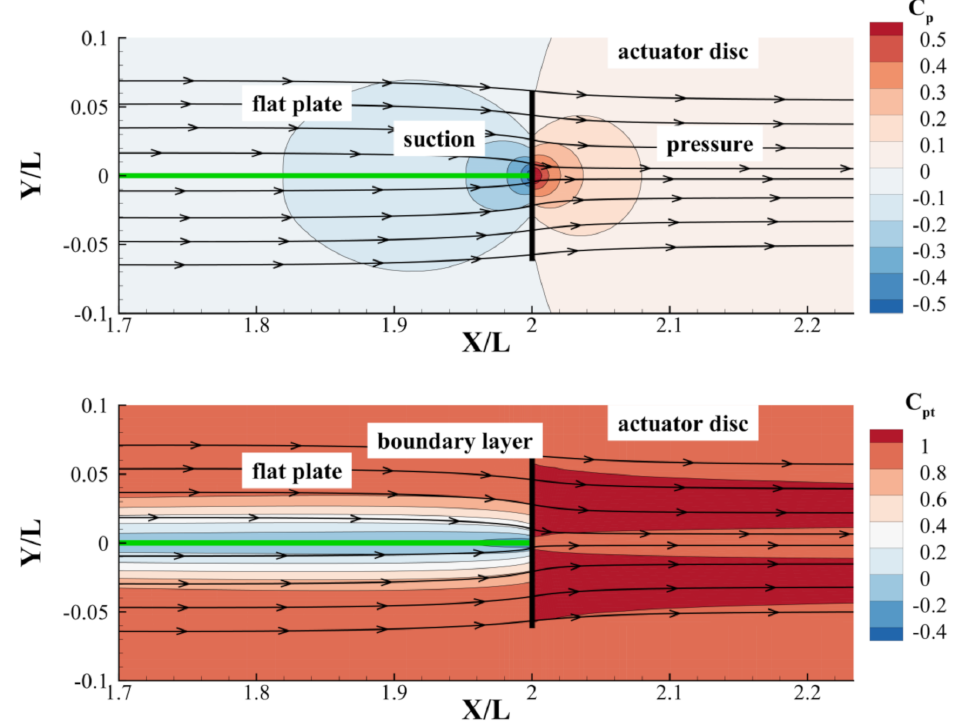
Figure 11. Contours of pressure coefficient ( top ) and the coefficient of total pressure ( bottom ) around the wake filling actuator disc, including a mirrored flow field